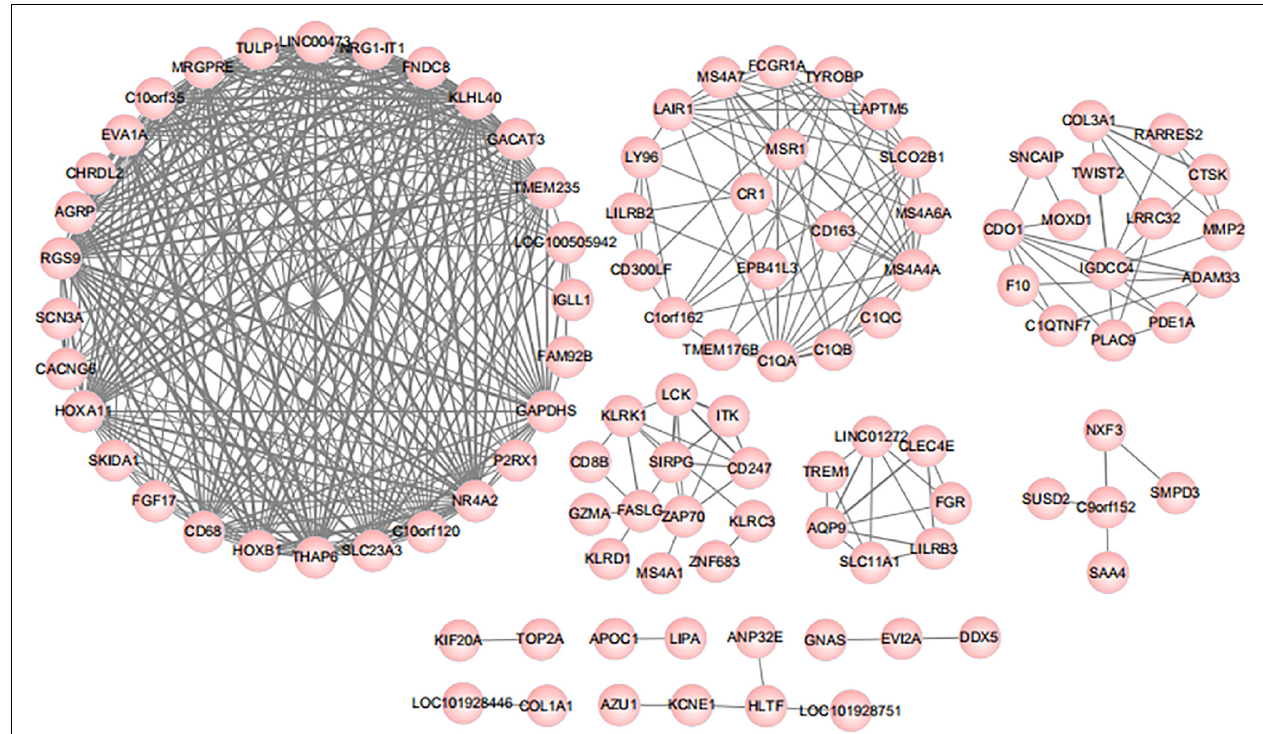
FIGURE 2 | Results of Pearson correlation analysis. According to the Pearson correlation coefficient, we obtained the correlations between genes, that is, the greater the connectivity, the greater the node size of the gene displayed.